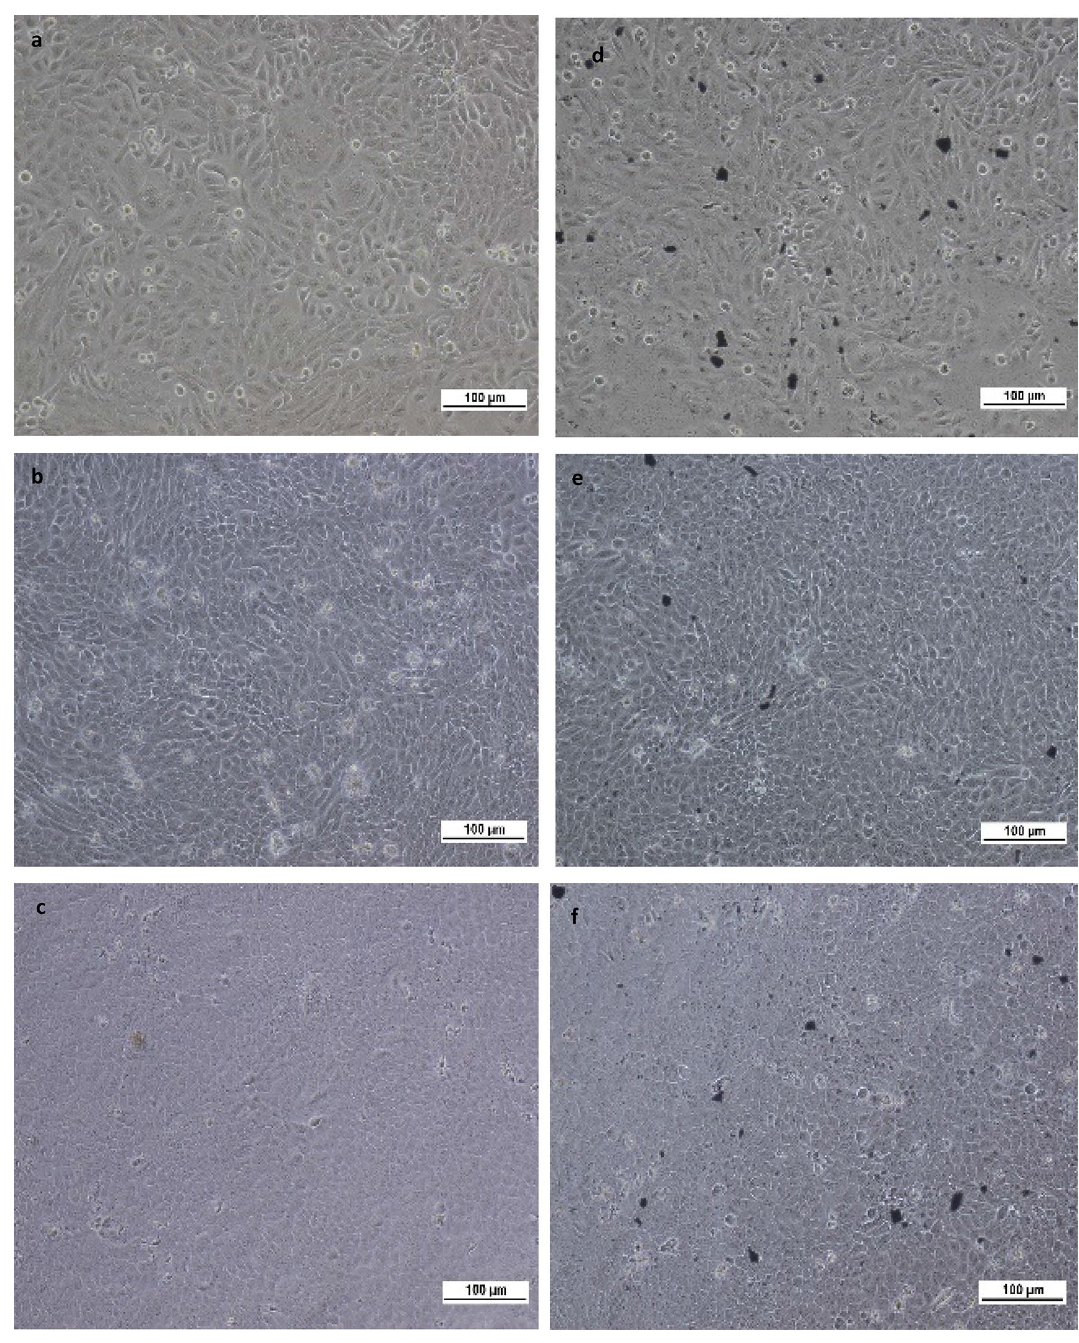
Figure 3. Microscopic characterization of non-GZ-treated HaCaT cells at ( a ) 24 h, ( b ) 48 h, ( c ) 72 h; and GZ-treated HaCaT cells at ( d ) 24 h, ( e ) 48 h, ( f ) 72 h. The presence of GZ nanocomposite did not apparently inhibit the viability of HaCaT cells. Treated cells appeared to be equally proliferative and retained comparable morphology as the control throughout 72 h of the incubation